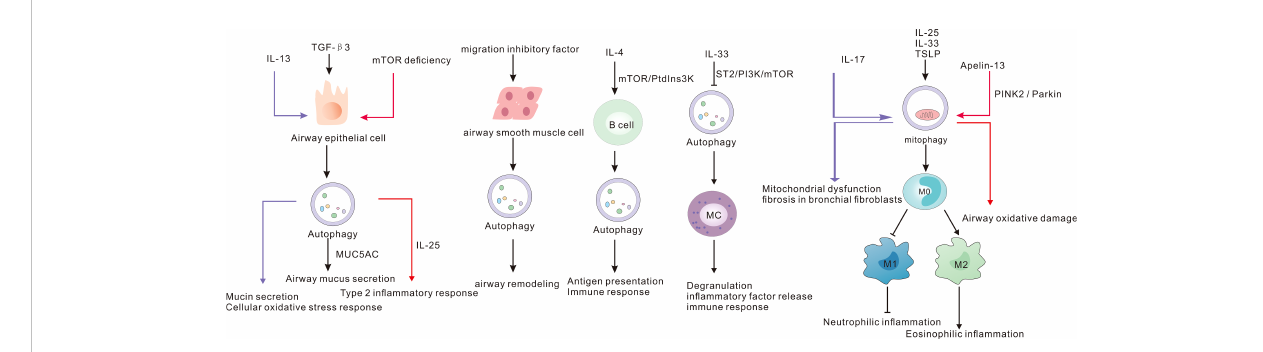
FIGURE 2 The cells and cytokines involved in asthma and